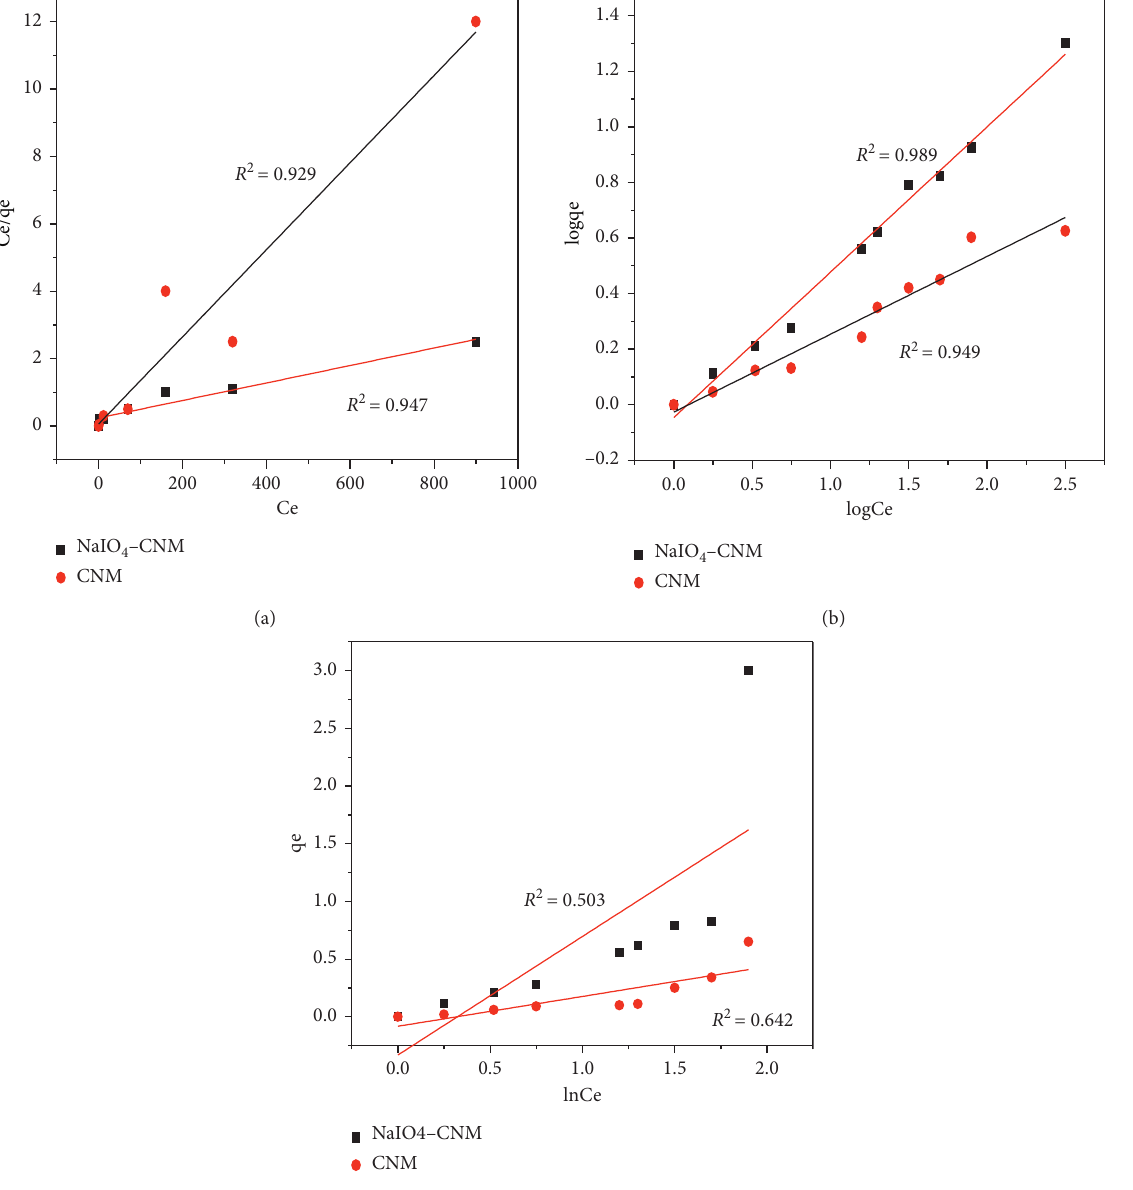
Table 3: Langmuir, Freundlich, and Temkin isotherm constants for Pb(II) ions adsorption by CNC and NaIO Isotherm models